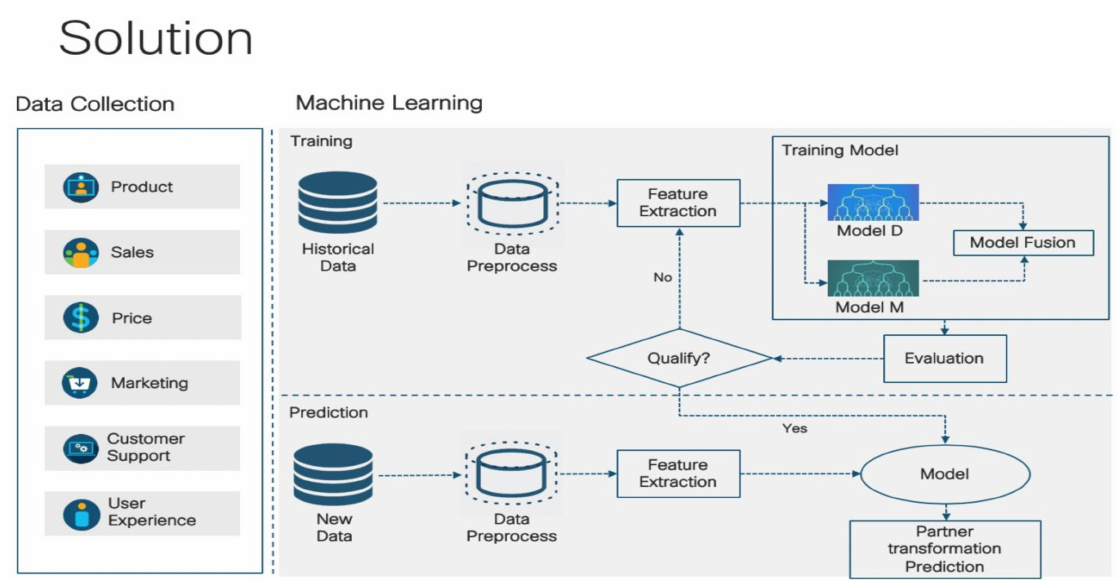
Figure 3. Machine-learning system solution architecture.